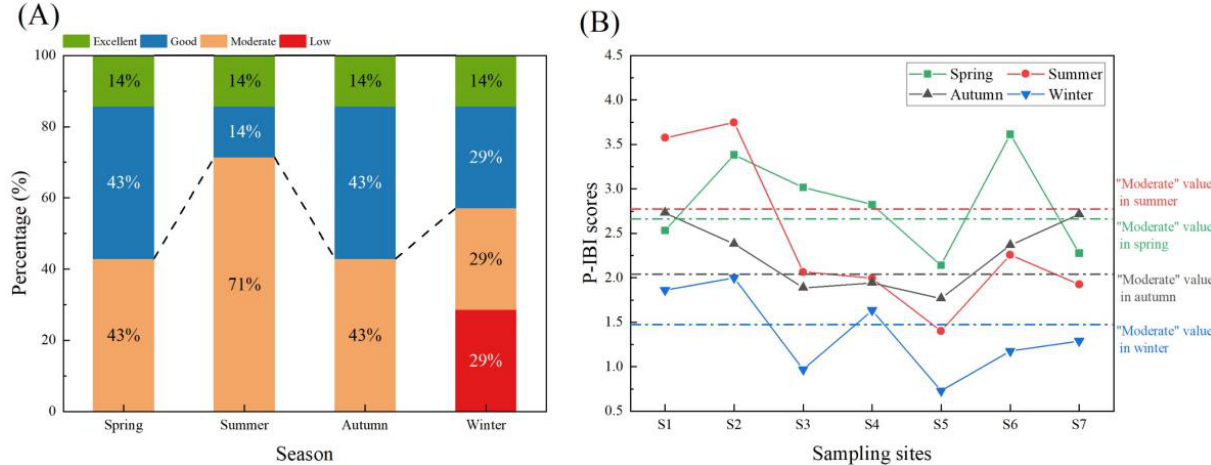
Figure 3. Spatiotemporal variation of the P – IBI. ( A ) Percentage composition of water quality grades in different seasons. ( B ) Spatial variation of the P – IBI at different sites.